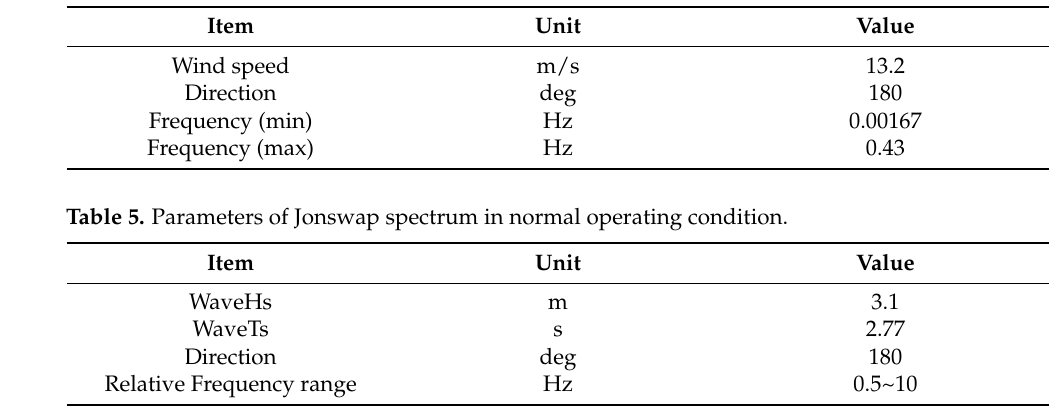
Table 4. Parameters of NPD spectrum in normal operating condition.